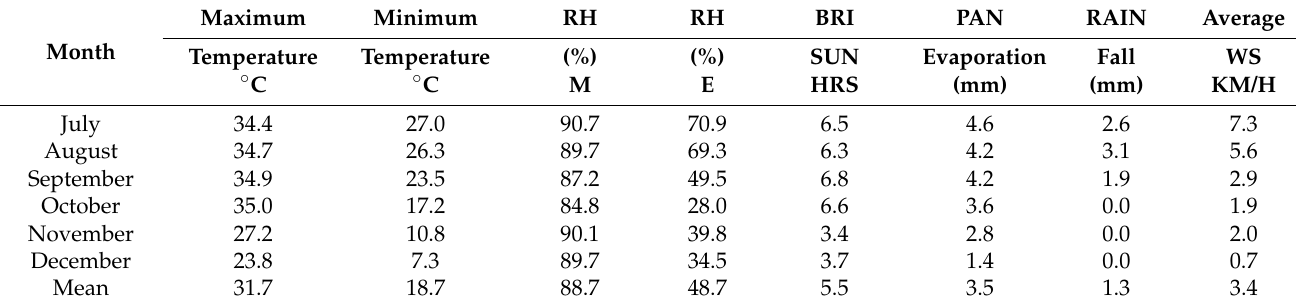
Table 1. Weather data during the field experiment.